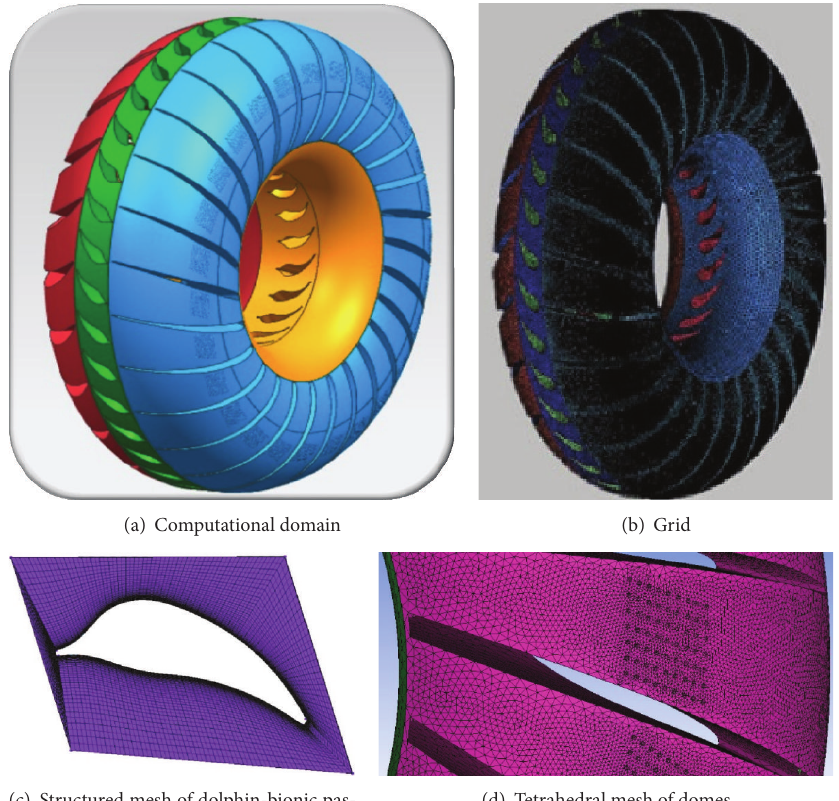
Figure 13: Tetrahedral mesh of pump and domes.